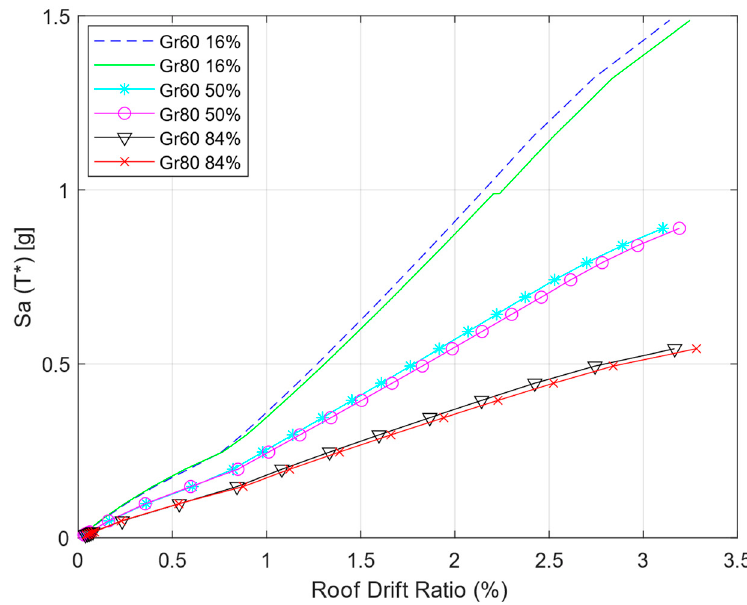
Figure 6. Fractile IDA curves for the buildings.